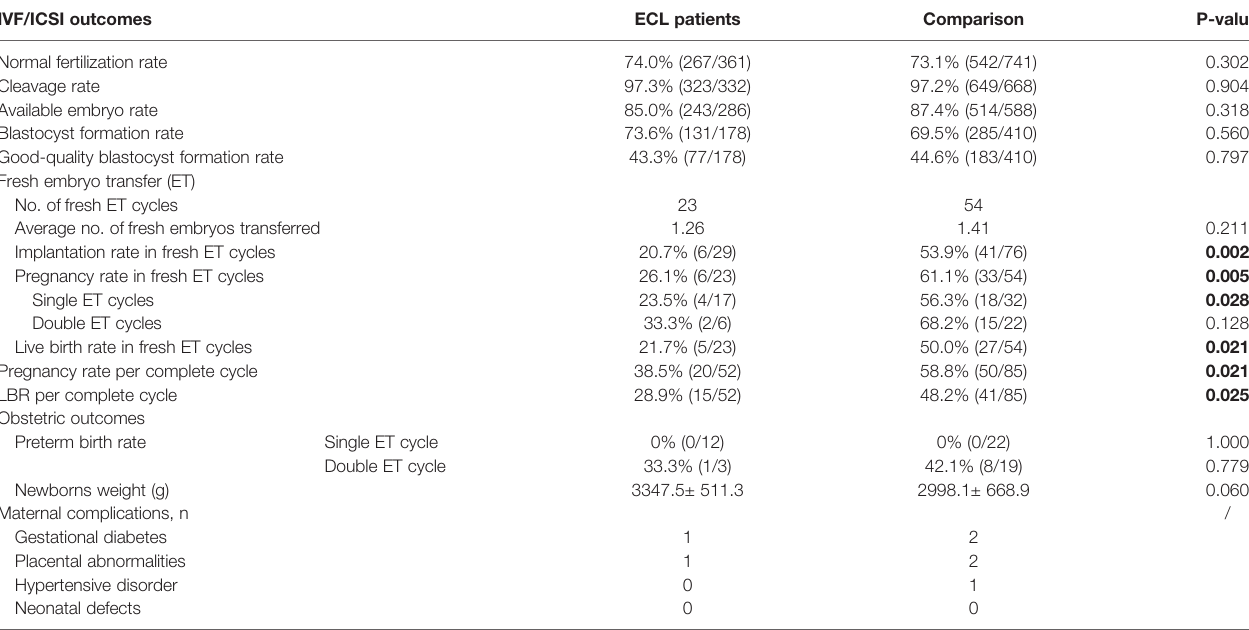
TABLE 3 | IVF/ICSI results and obstetric outcomes of ECL and comparison groups. IVF/ICSI outcomes ECL patients Comparison Normal fertilization